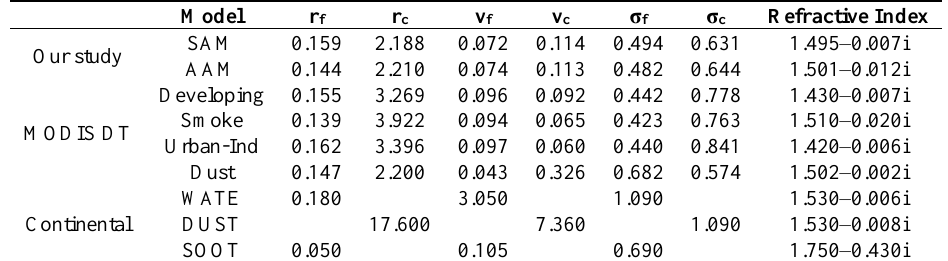
Table 1. Comparing SAM and AAM with MODIS DT algorithm aerosol models and the continental aerosol model at an aerosol optical depth (AOD) of 0.5